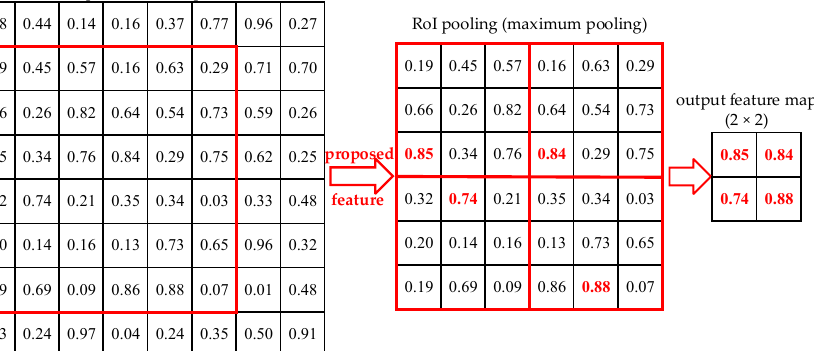
Figure 4. Operating principle of RoI pooling layer.